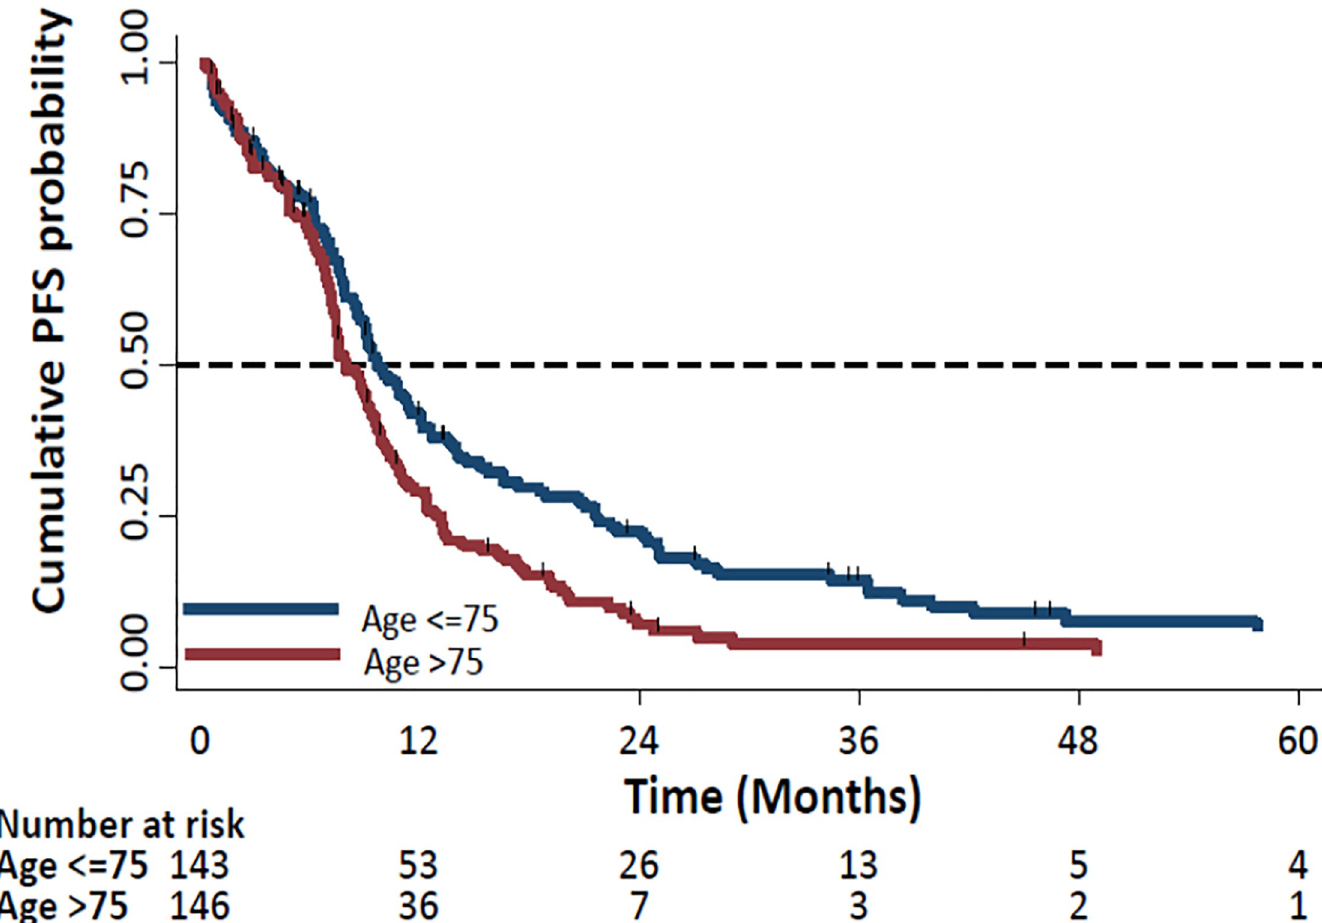
Fig 5. Kaplan Meier Curves of progression-free survival (PFS) by age ( > 75 vs. � 75 years).